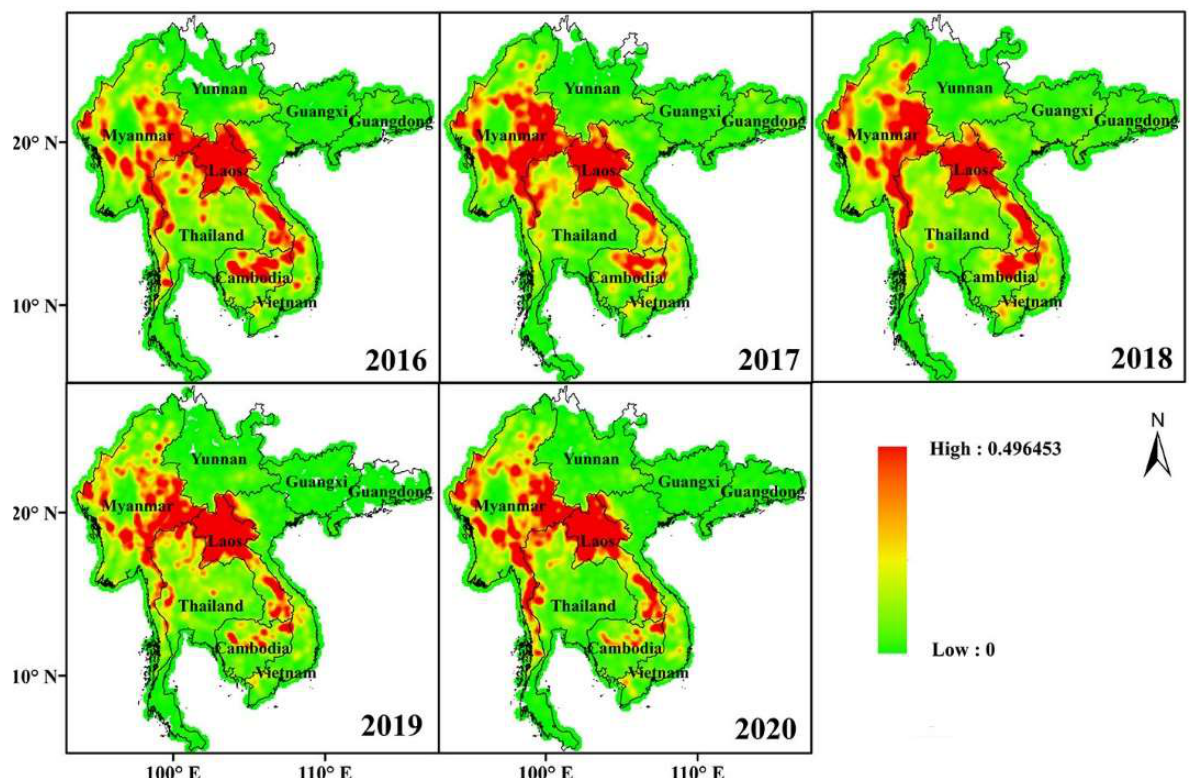
Figure 2. Fire point distribution density map in the study area. (High: 0.496453 is the calculated value of nuclear density, indicating the number of fire points per kilometer).